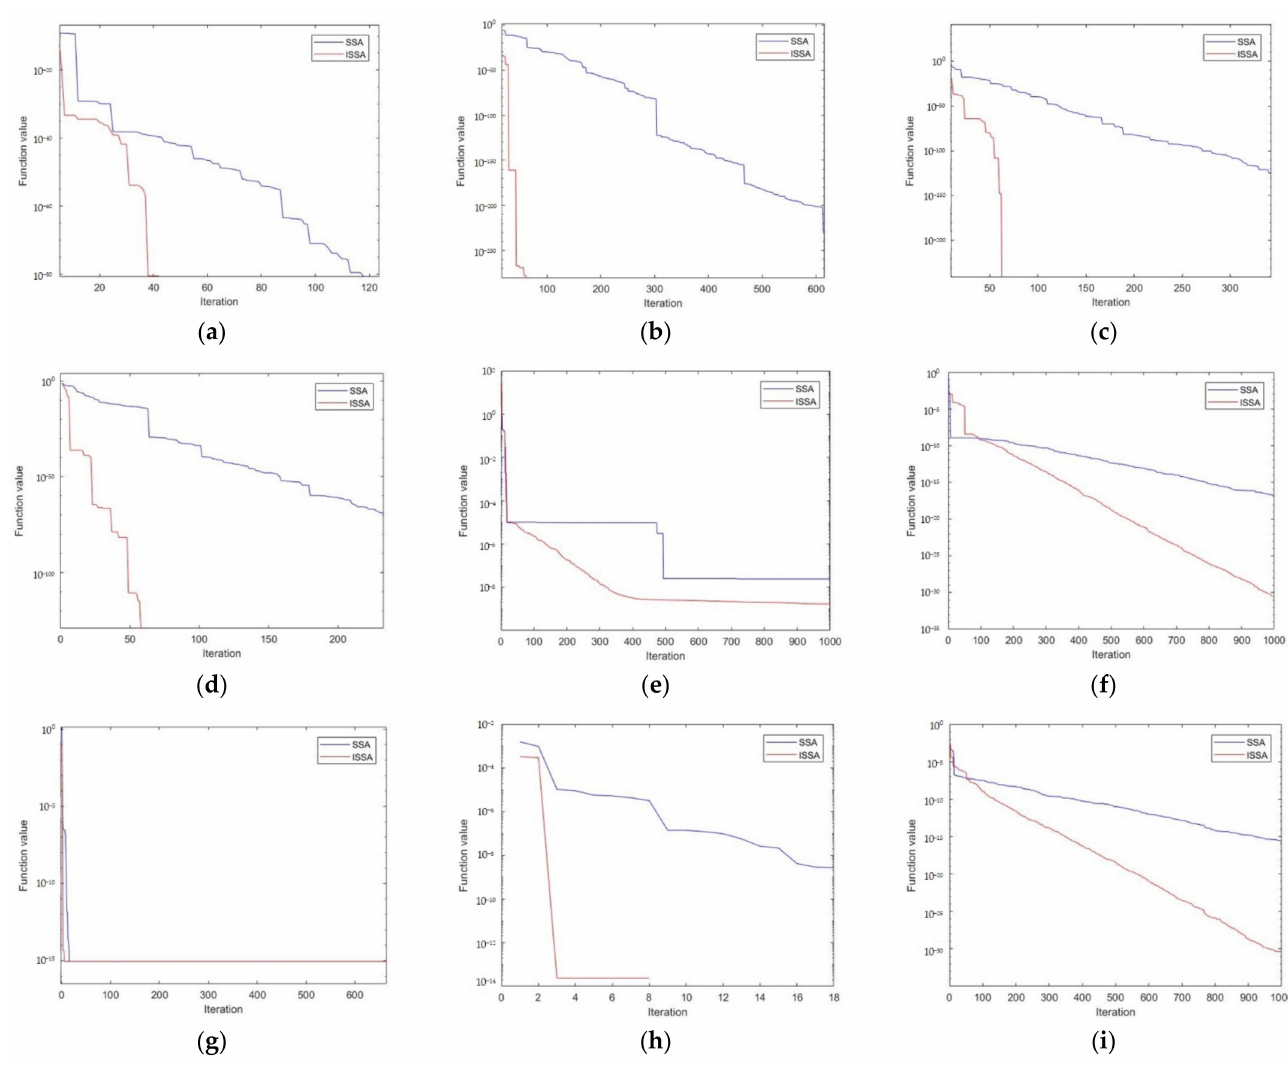
Figure 4. The convergence characteristics of SSA and ISSA on test functions. ( a ) Convergence curve of F1; ( b ) Convergence curve of F2; ( c ) Convergence curve of F3; ( d ) Convergence curve of F4; ( e ) Convergence curve of F5; ( f ) Convergence curve of F6; ( g ) Convergence curve of F7; ( h ) Conver- gence curve of F8; ( i ) Convergence curve of